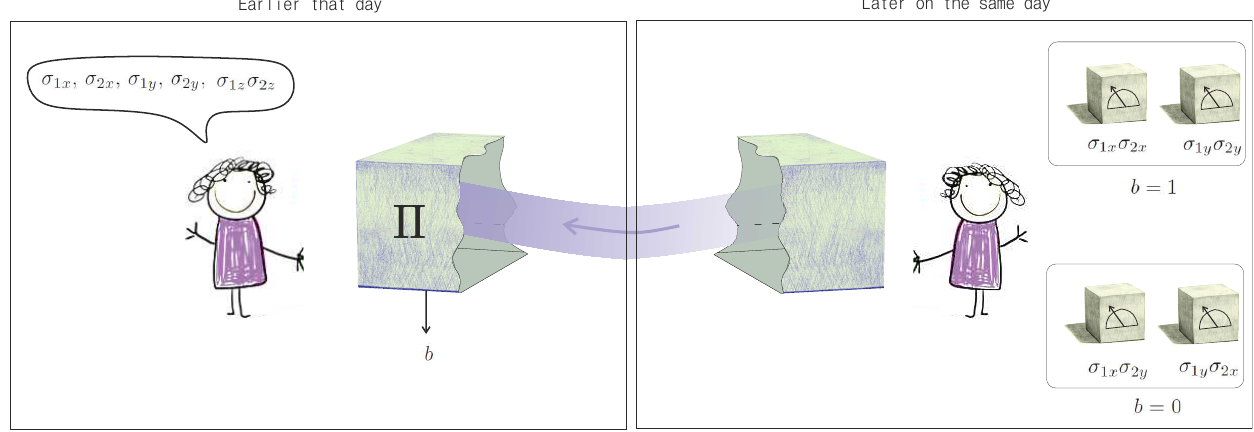
Figure 1. Depiction of the protocol. First, Alice finds out the values of the (contextual) hidden variables and uses them to calculate the value of a bit b . Later she establishes the context by choosing which set of observables to measure. Her later choice determines the value of b , sending it back in